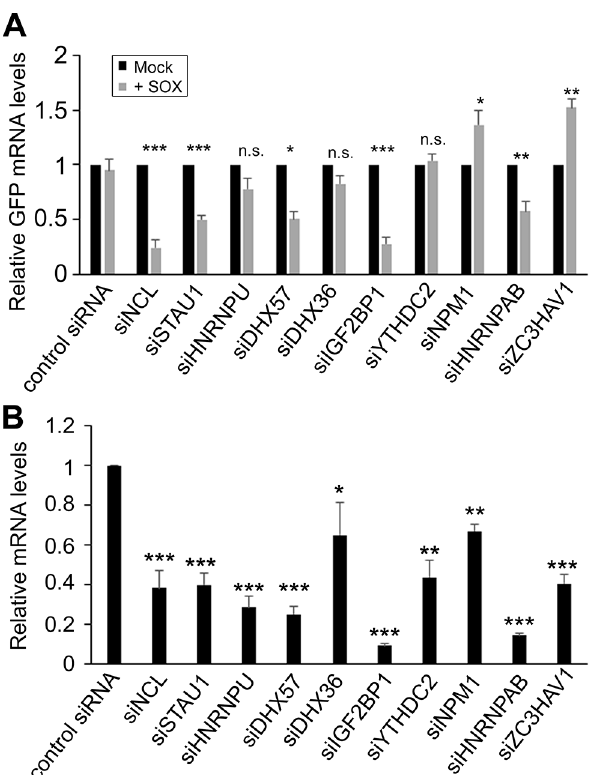
Fig 2. SRE-binding proteins contribute to protection from SOX-mediated decay. (A) 293T cells were transfected with siRNAs targeting each of indicated SRE binding proteins. 48h post-siRNA transfection, cells were further transfected with GFP-3 ’ IL-6 plasmid in the presence or absence of SOX. Cells were harvested 24h later and subjected to RT-qPCR to measure GFP and 18S levels. (B) Efficiency of siRNA-mediated depletion of the indicated SRE binding proteins was assessed by